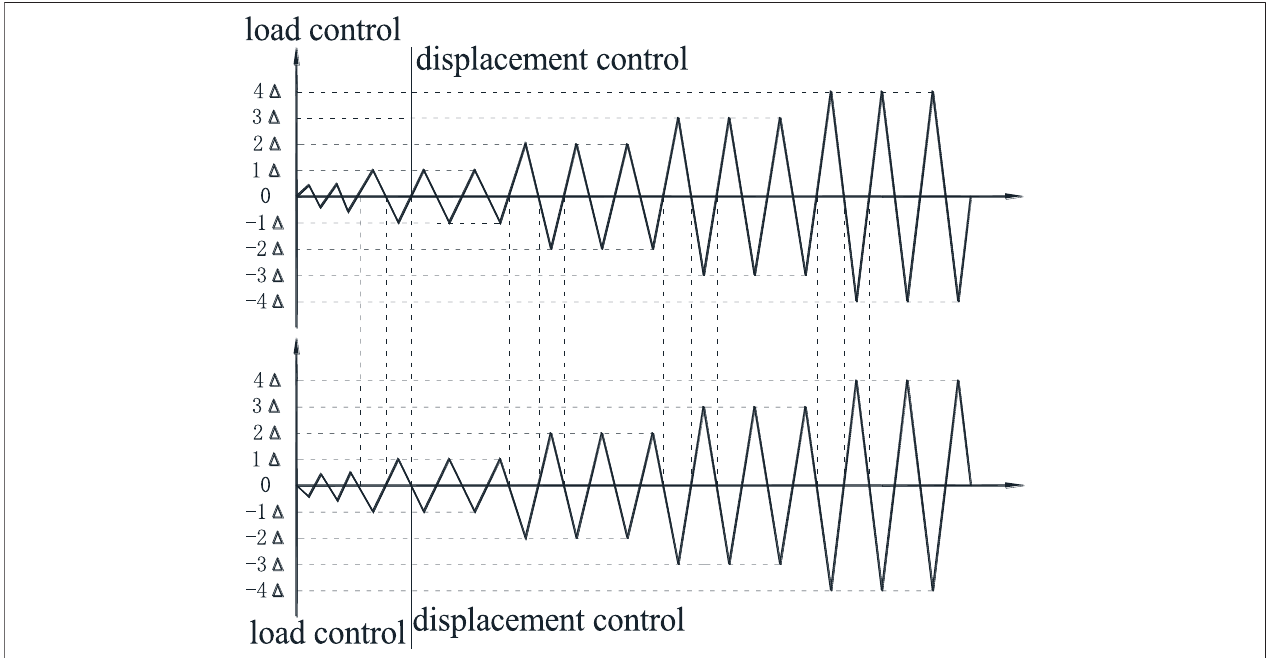
FIGURE 15 | Loading criterion (Xiang et al., 2017; Xiang et al., 2019).